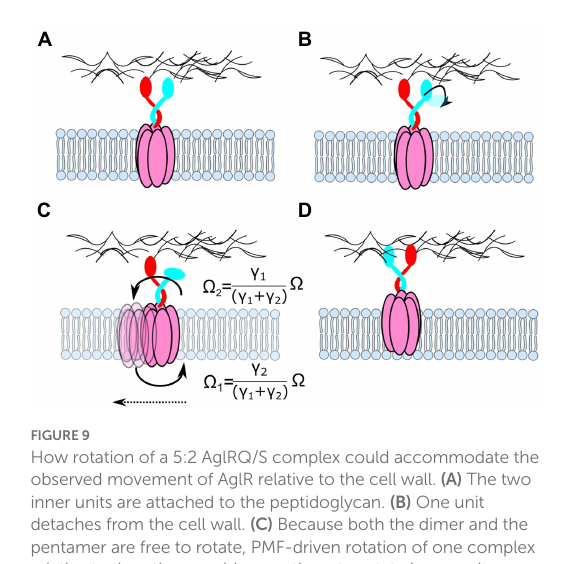
FIGURE 9 How rotation of a 5:2 AglRQ/S complex could accommodate the observed movement of AglR relative to the cell wall. (A) The two inner units are attached to the peptidoglycan. (B) One unit detaches from the cell wall. (C) Because both the dimer and the pentamer are free to rotate, PMF-driven rotation of one complex relative to the other would cause them to rotate in opposite directions, with angular velocities ( Ω ) depending on the ratio of the drag coefficients ( γ ). The detached domain binds again to the peptidoglycan, but it binds at a different